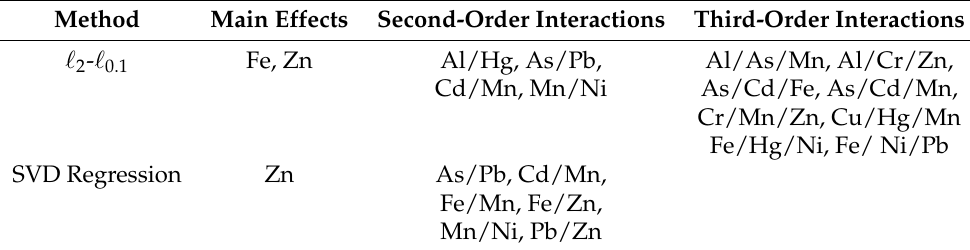
Table 9. Important elements and